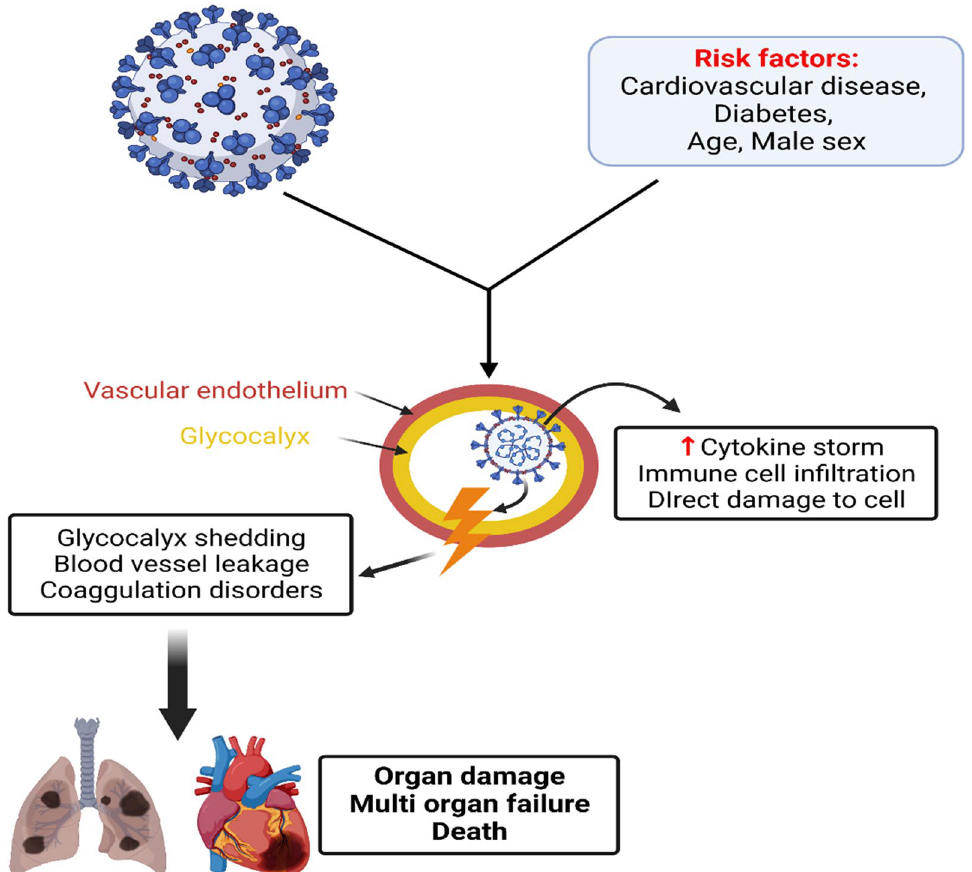
Fig. 3 Glycocalyx injury in Covid‑19 and systemic complications: Co‑morbidities like old age, diabetes and cardiovascular disorders together with SARS‑CoV‑2 induce glycocalyx injury with development of endothelial dysfunction, blood vessel leakage and coagulation disorders. These changes lead to organ damage, multi‑organ failure, and death. Covid‑19‑induced glycocalyx injury is mediated by cytokine storm, immune cell infiltration, and direct cellular